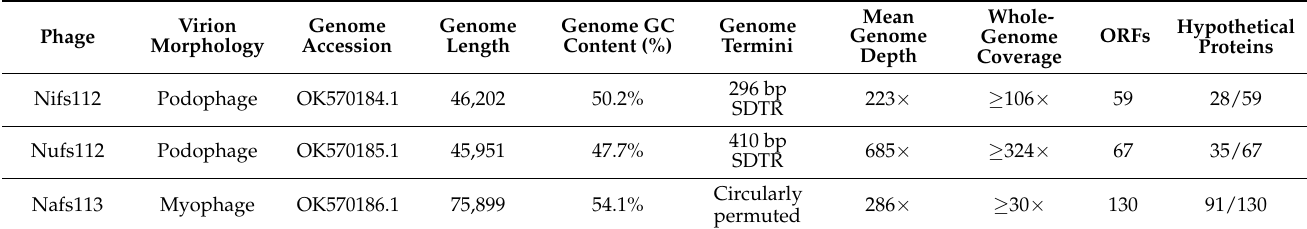
Table 2. Overview of the Pantoea phage Nifs112, Nufs112, and Nafs113